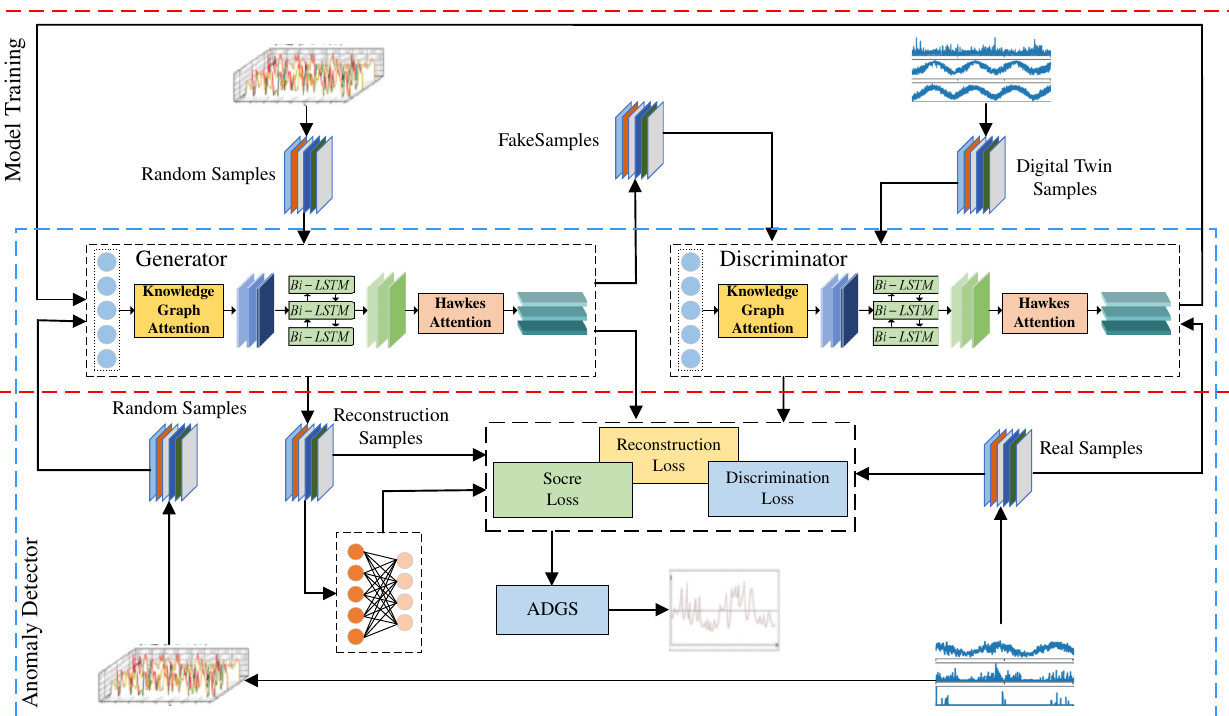
Figure 3. The structure of GAN for anomaly detection.